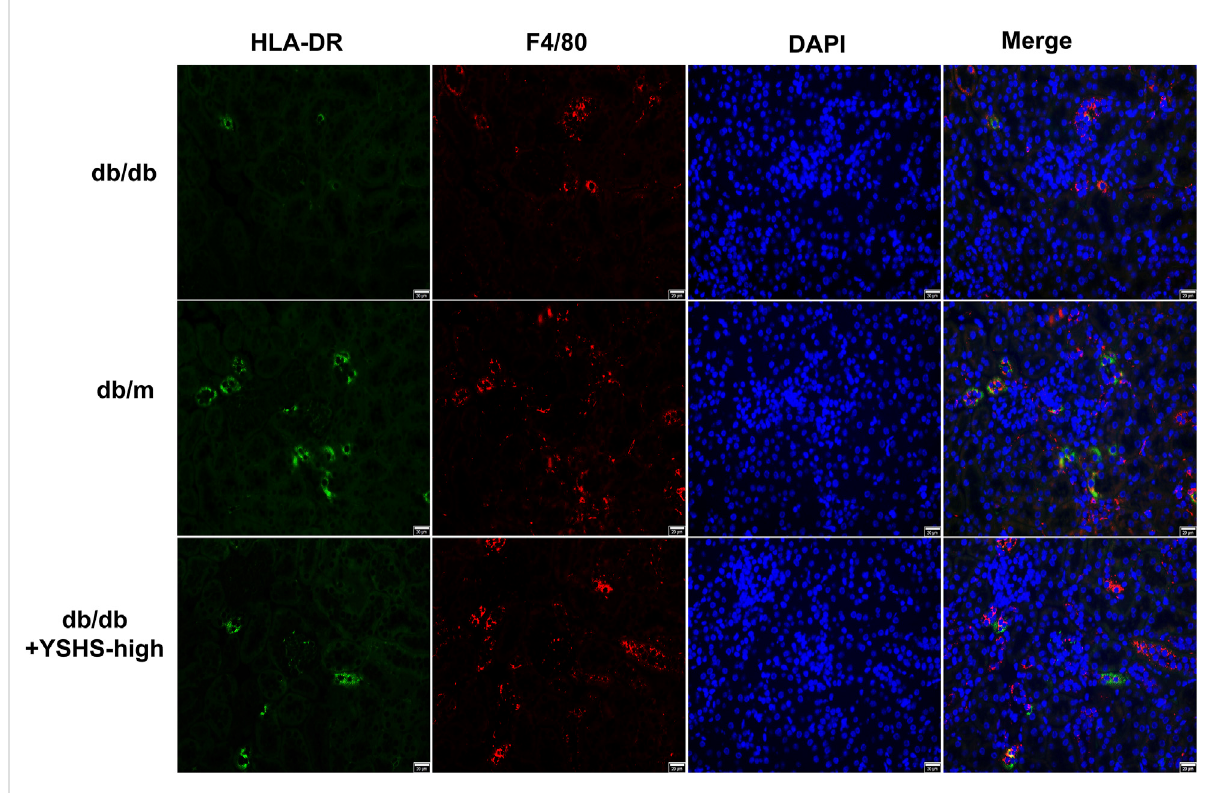
FIGURE 9 Evaluation of the role of YSHS in the alteration of macrophage in fi ltration and M1 polarization in kidney tissues in db/db mice. IF detected the distribution of HLA-DR and F4/80 fl uorescence in the kidney tissues of mice in each group. The size of the scale is 20 μ